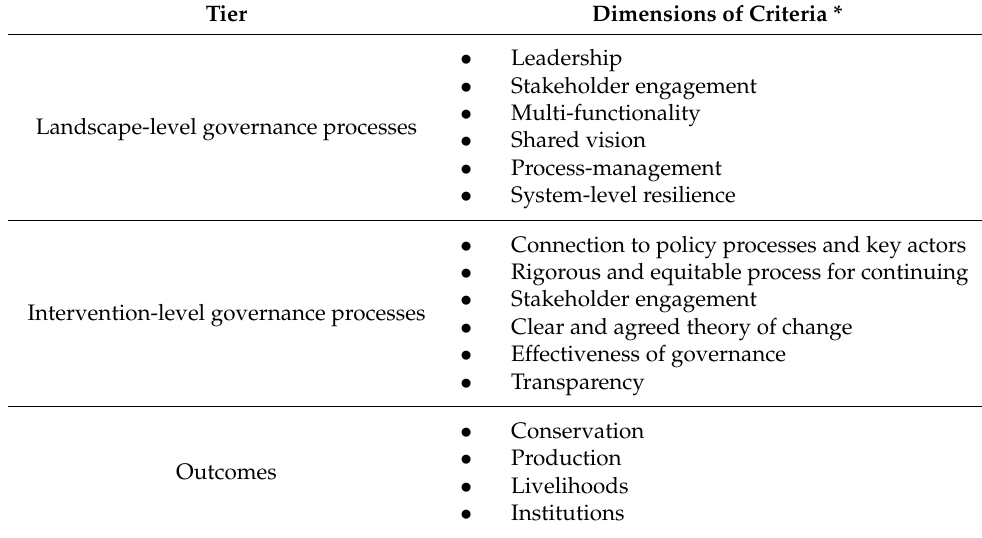
Table 2. Degradation—three tier assessment